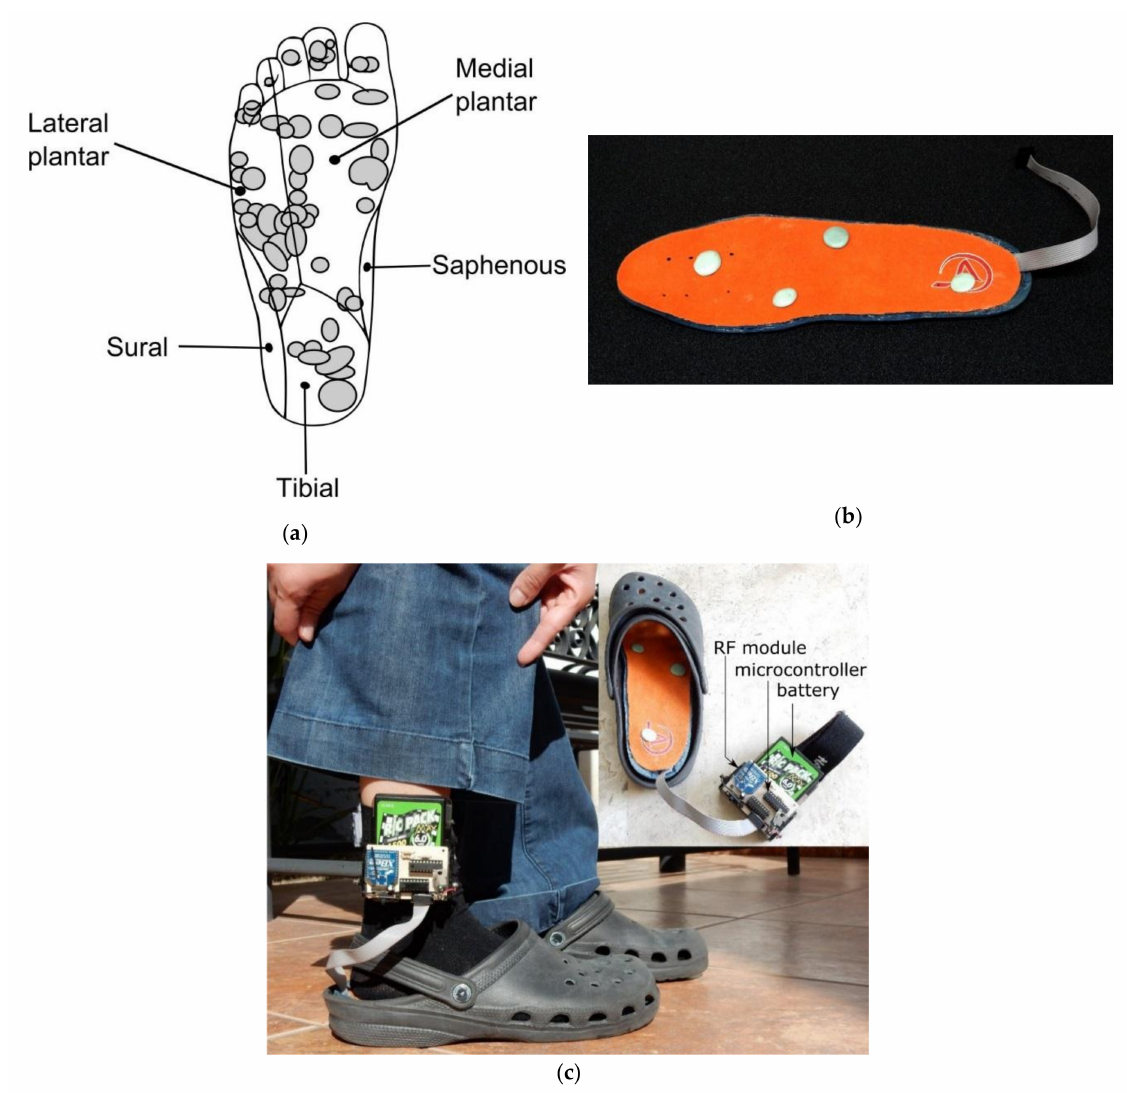
Figure 3. On-shoe tactile display: ( a ) Distribution of fast adapting type I (FAI) mechanoreceptors sensitive to vibrotactile stimulation in the foot sole, Reproduced with permission from P.M. Kennedy, J.T. Inglis, Journal of Physiology; published by John Wiley and Sons, 2004.; ( b ) Prototype; and ( c ) Fully wearable device with wireless